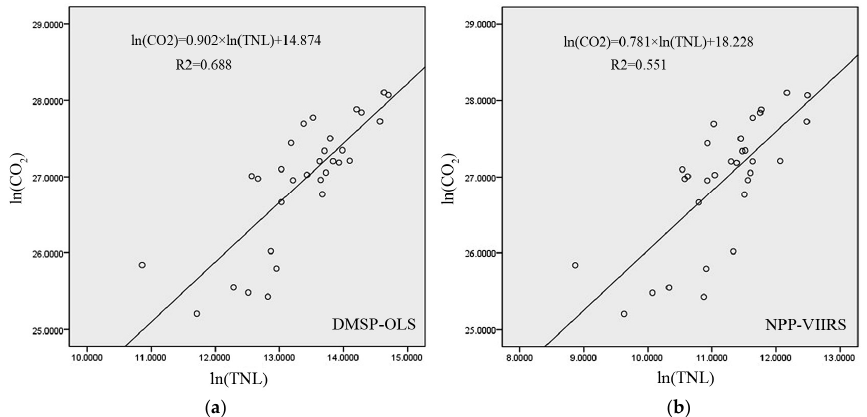
Figure 1. ( a , b ) Scatter plots of TNL vs. CO 2 emissions with the log-log regression model at provincial-level regions: DMSP-OLS and NPP-VIIRS.